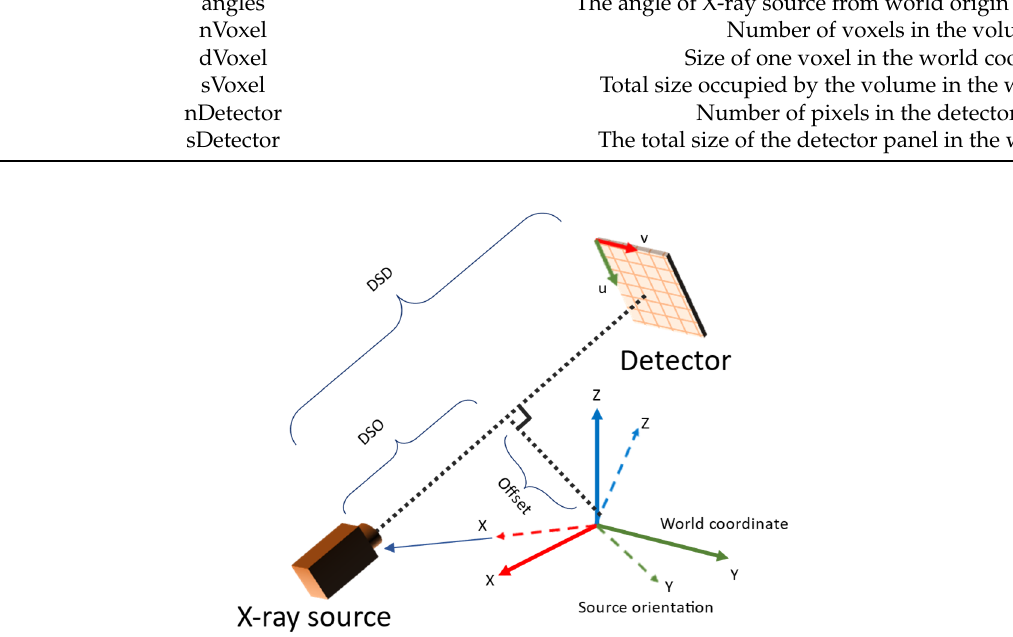
Figure 4. Relation between TIGRE geometry parameters and camera system setup.